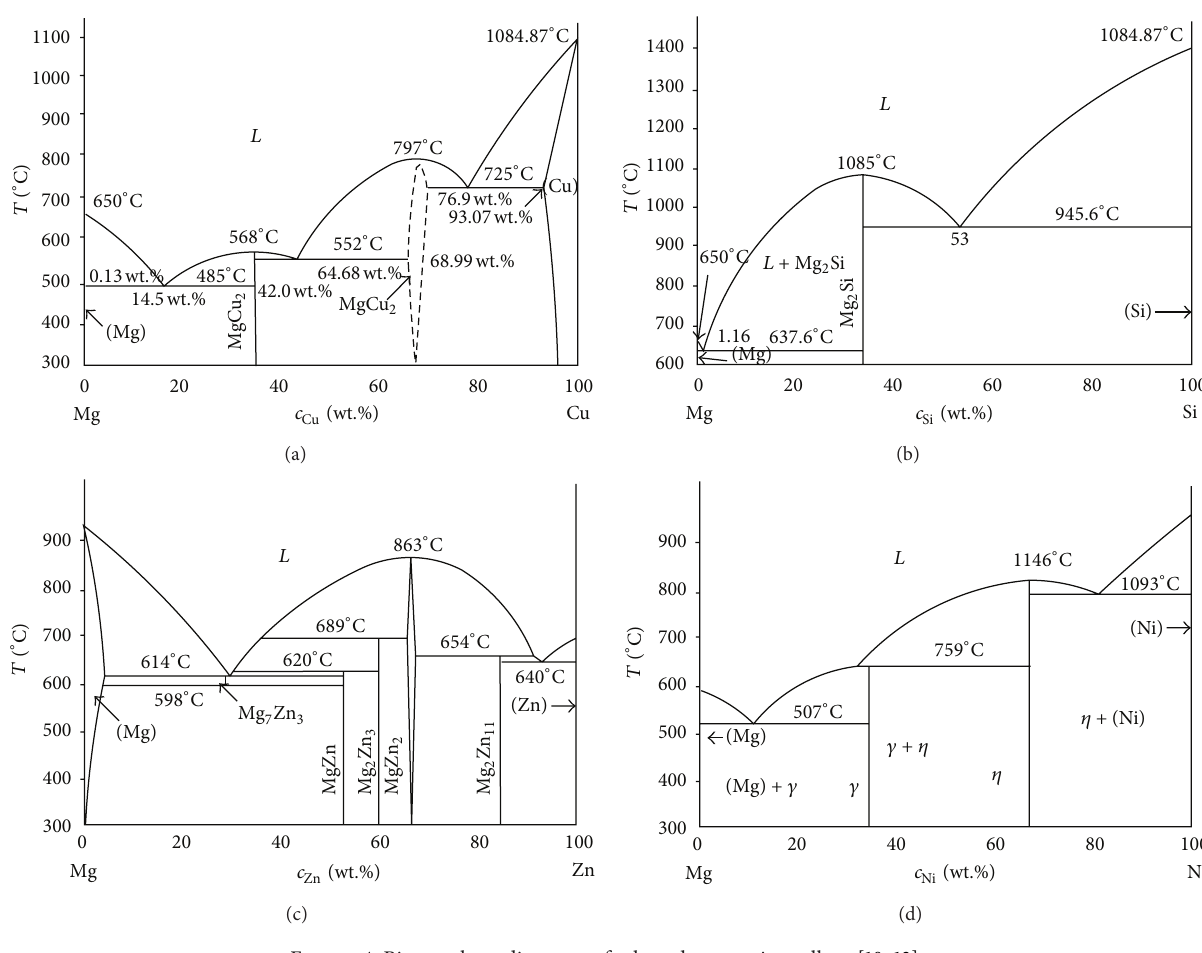
Figure 4: Binary phase diagrams of selected magnesium alloys [10, 13].